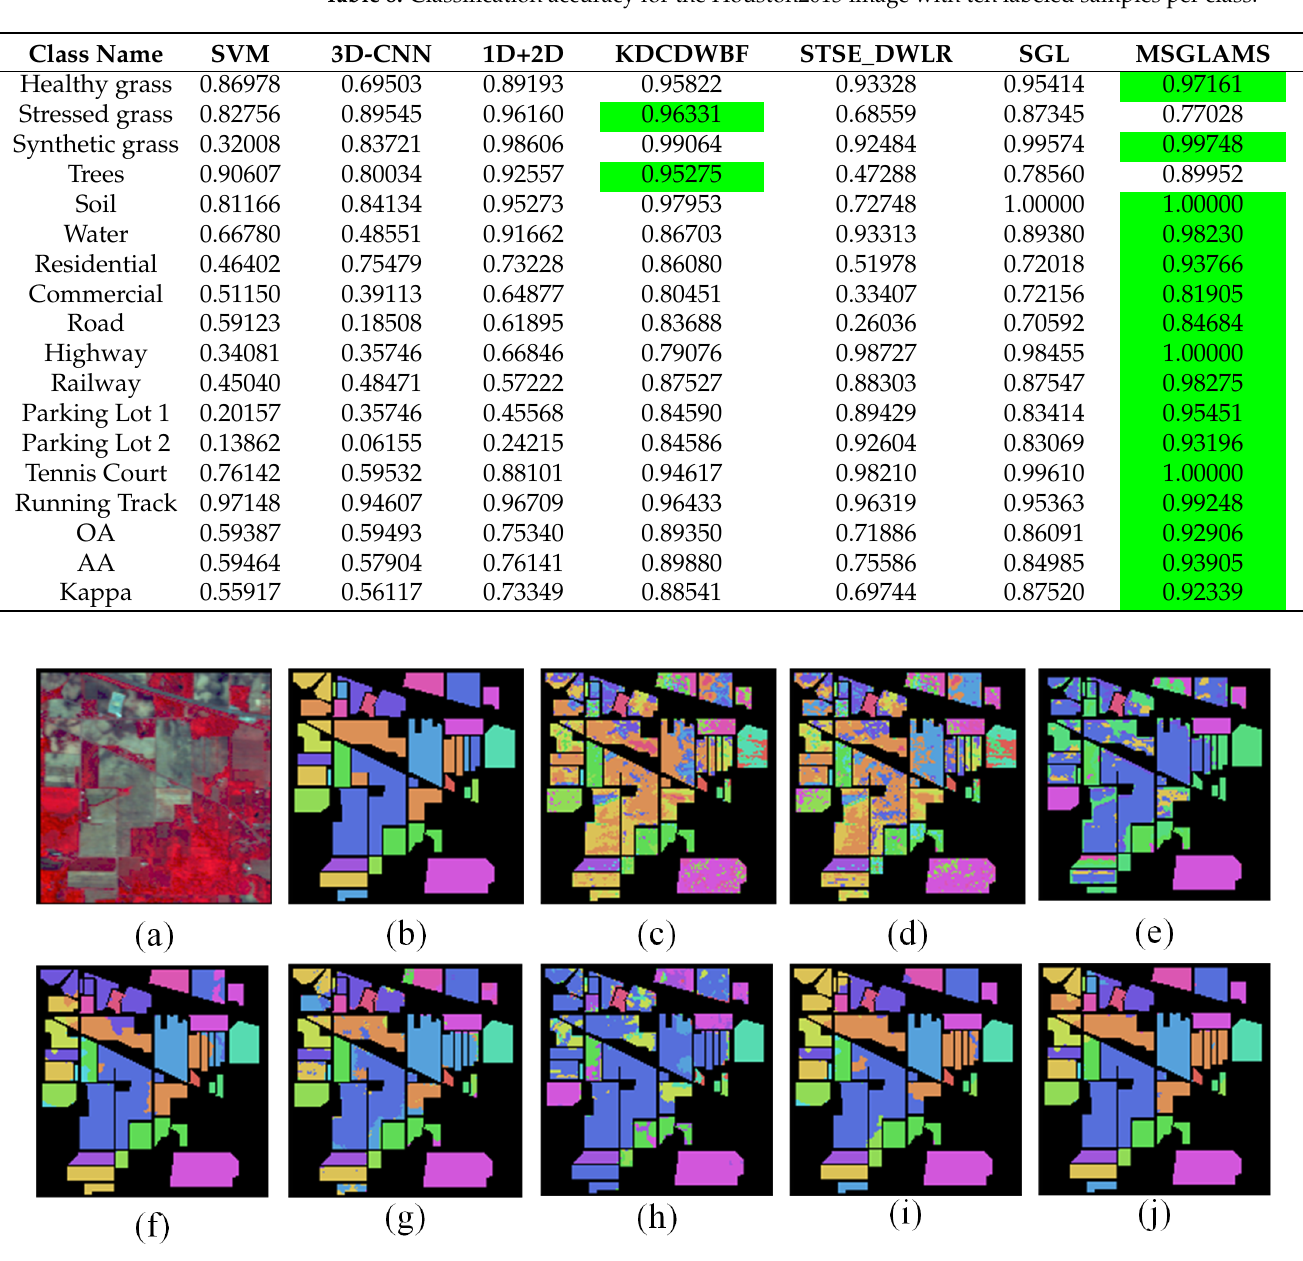
Table 8. Classification accuracy for the Houston2013 image with ten labeled samples per class.